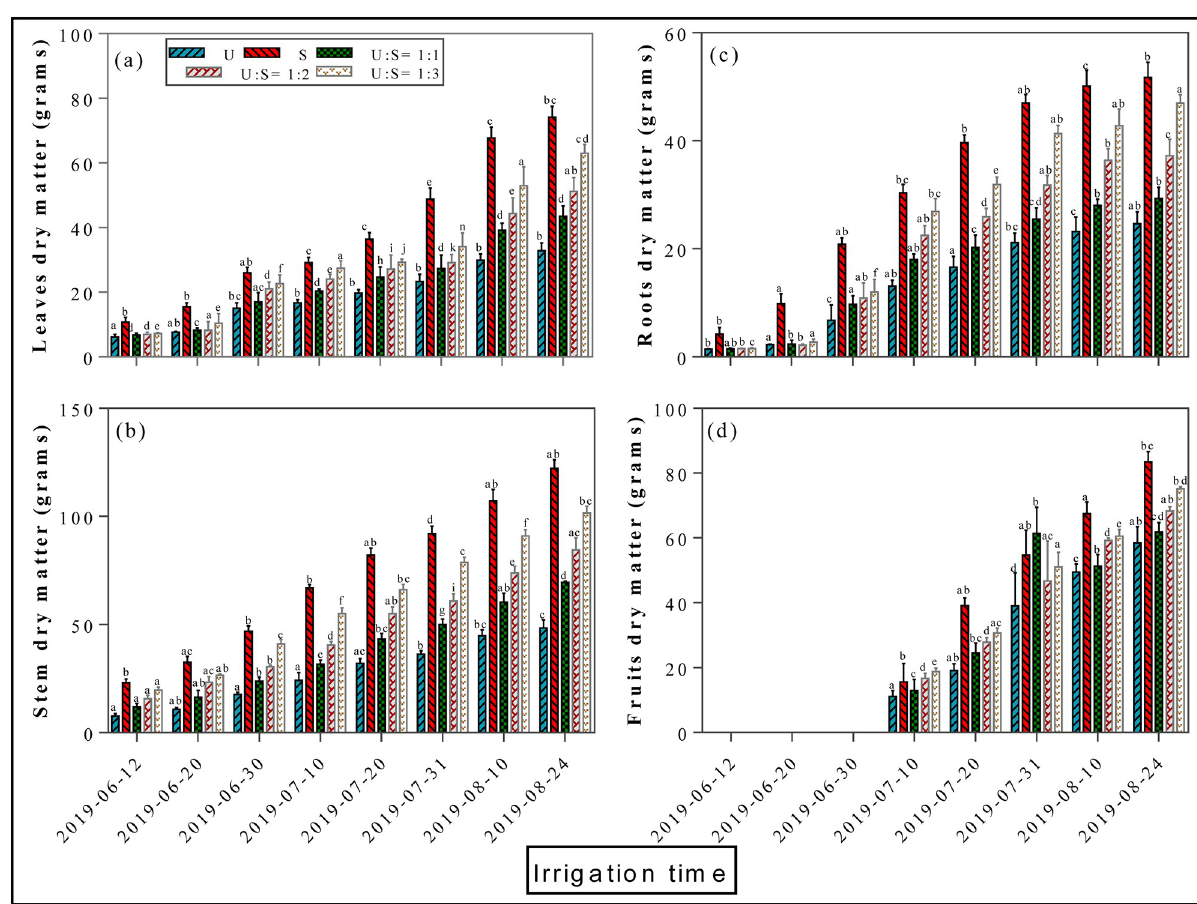
Fig 2. Effects of different mixing ratio irrigation methods on the accumulation dry matter: Fig (2a) represents leaves dry matter; (2b) represents stem dry matter; (2c) represent roots dry matter; and (2d) represent fruits dry matter, respectively. Data were presented as the mean ± standard error (SE) of three replicates at a significance level of p < 0.05 (based on